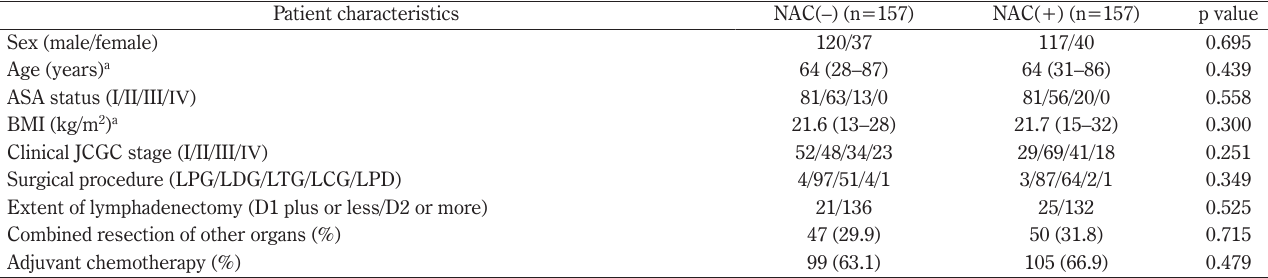
Table 3 Background and treatment-related factors of all patients who underwent LG with and without NAC, after propensity score matching